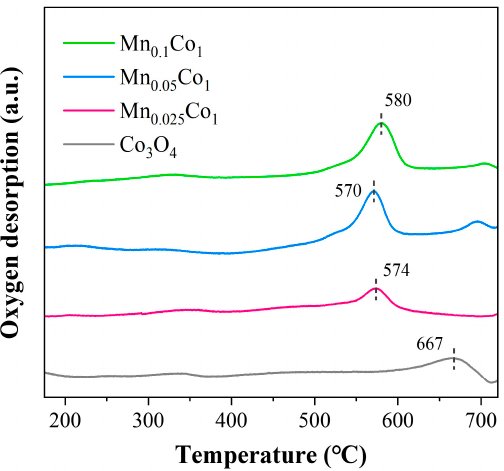
Figure 5. O 2 -TPD profiles of the Co 3 O 4 and Mn x Co 1 ( x = 0.025, 0.05, 0.1) catalysts.